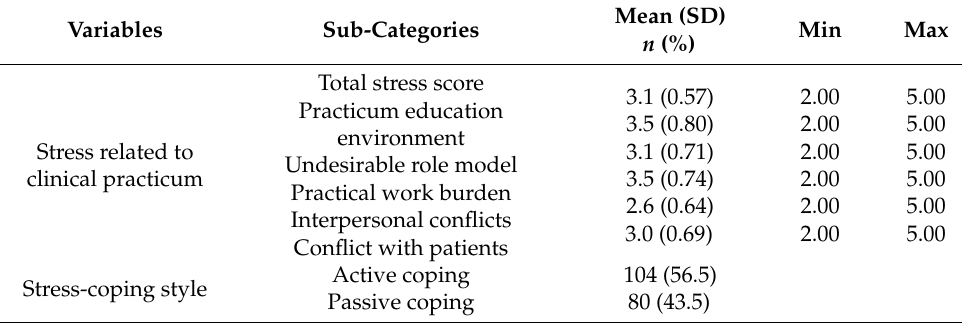
Table 2. Descriptive statistics of variables ( n = 184).